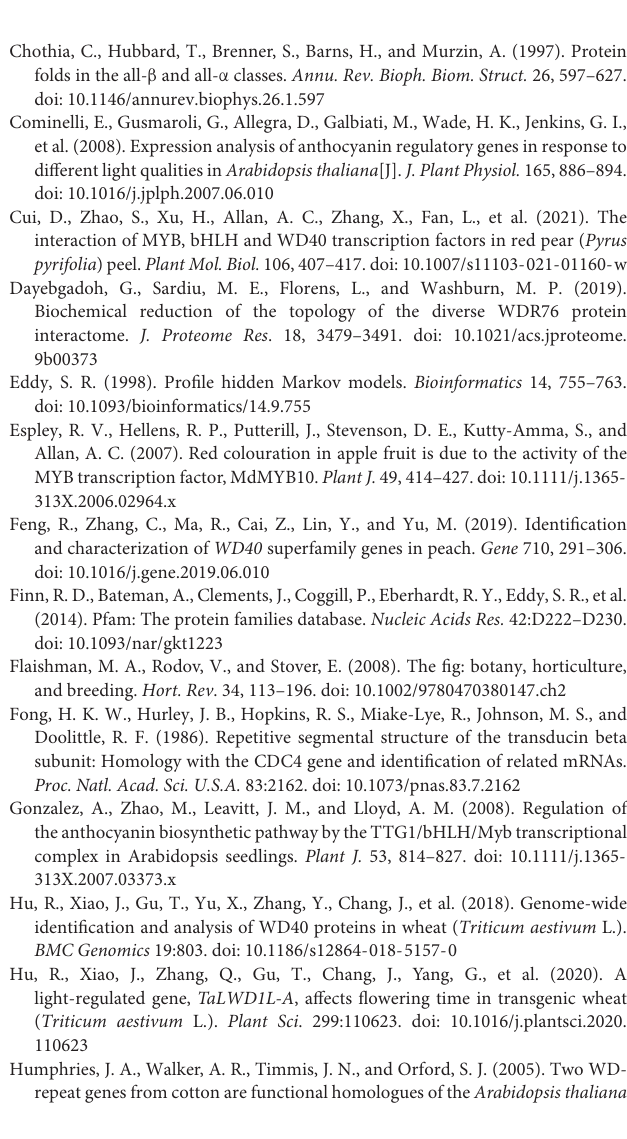
Supplementary Figure 1 | Collinearity analysis of FcWD40 genes; circle plot created with MCScanX tool. Identified collinear genes are linked by colored lines. Supplementary Figure 2 | Phylogenetic analysis of 66 FcWD40s with predicted nuclear localization and at least 4 WD-repeat (WDR) motifs. Supplementary Figure 3 | Phylogenetic analysis of FcWD40s and TTG1s of Arabidopsis thaliana , Malus domestica , Pyrus pyrifolia , Fragaria × ananassa , Camellia sinensis , Punica granatum , G ossypium hirsutum , and Medicago truncatula . FcWD40-97 is indicated with red dot. Blue color background indicates TTG1 subgroups, and red star indicates potential TTG1 homolog in fig. Supplementary Figure 4 | Interaction of control combinations in vivo